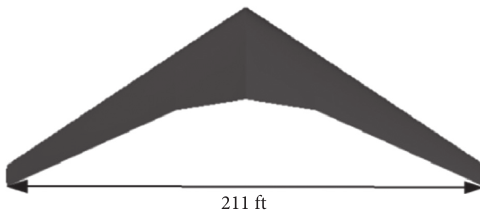
Figure 3: Geometric model of B747-400